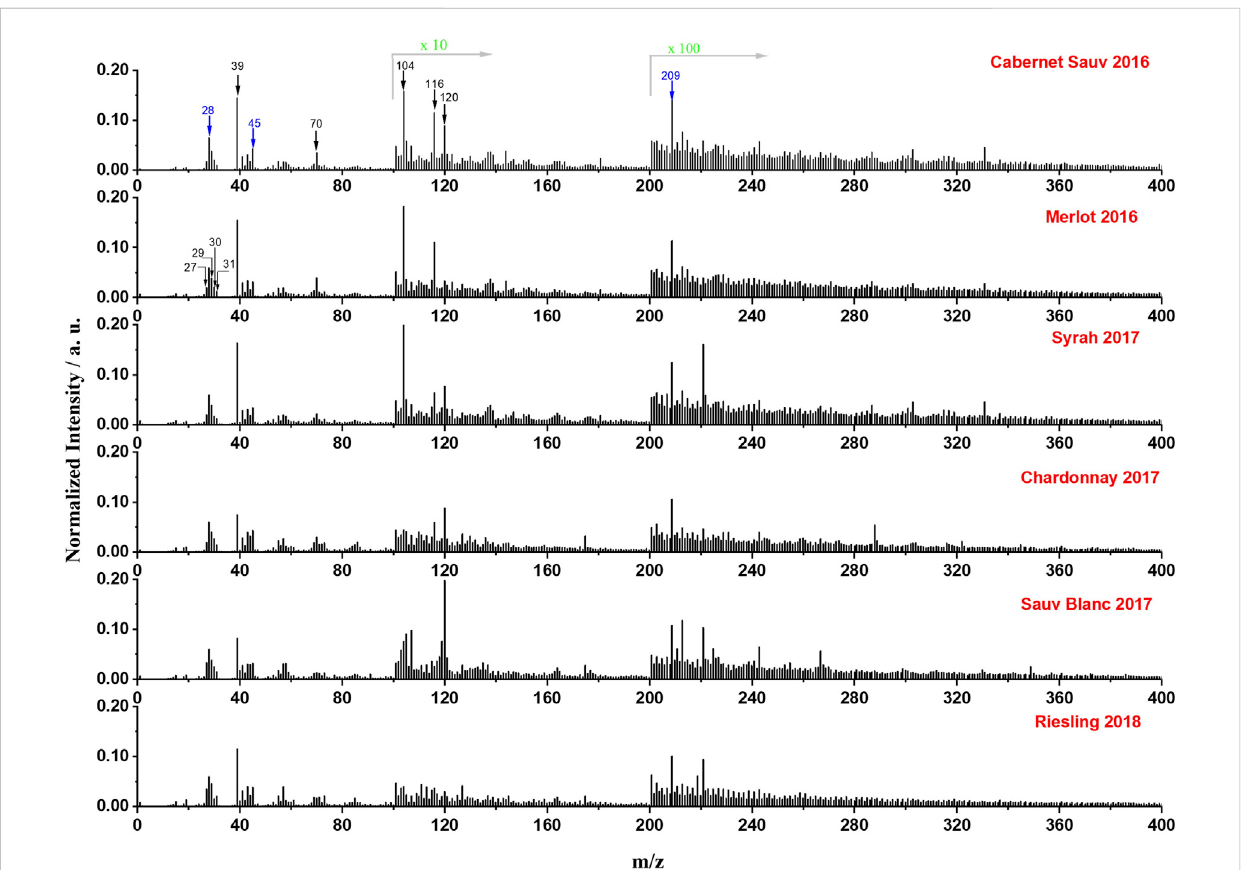
Normalized mass spectra (normalized to total intensity) of the six representative wines from a single manufacturer obtained by in situ liquid SIMS in positivemode.Theintensityofpeaksintherangeof101 – 200and201to400wasampli fi edby10timesand100times,respectively.Severalrepresentative ions from wines are marked by black arrows, and background signals from SiN membrane or the primary ion beam were marked by blue